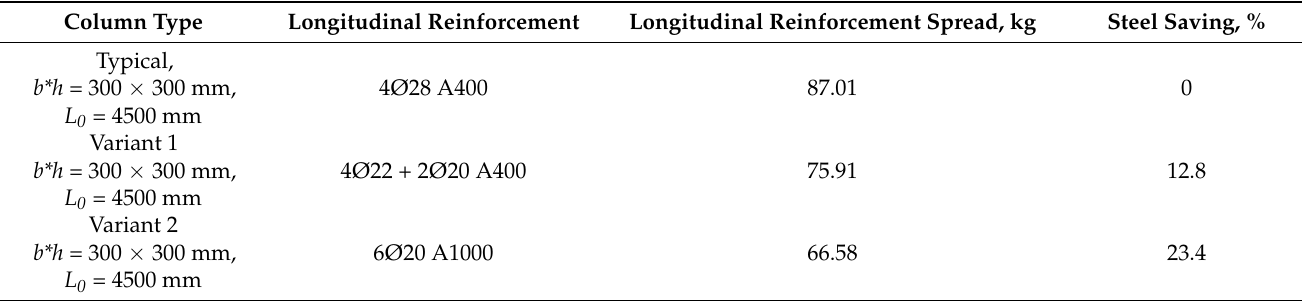
Table 10. Steel spread in a reinforced concrete column when using fiber reinforcement. Longitudinal